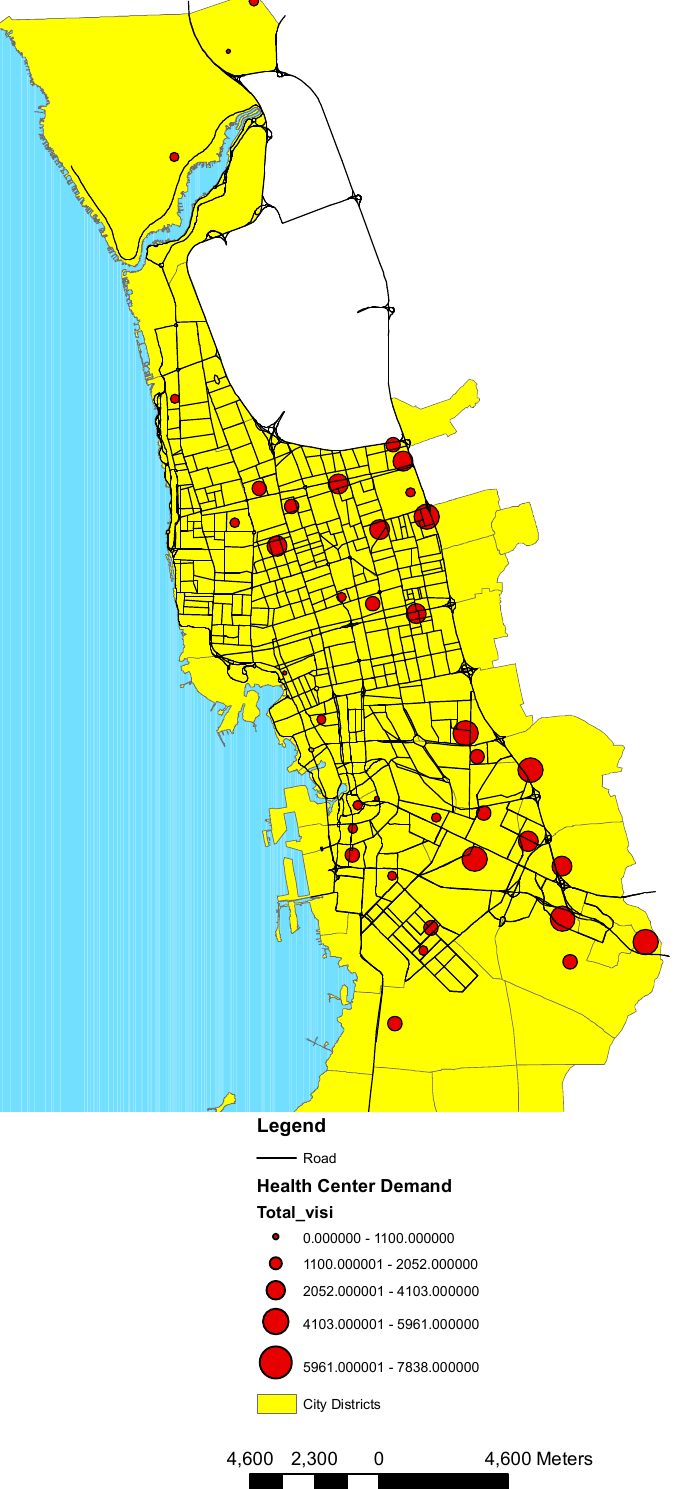
Figure 1. Health demand classification.